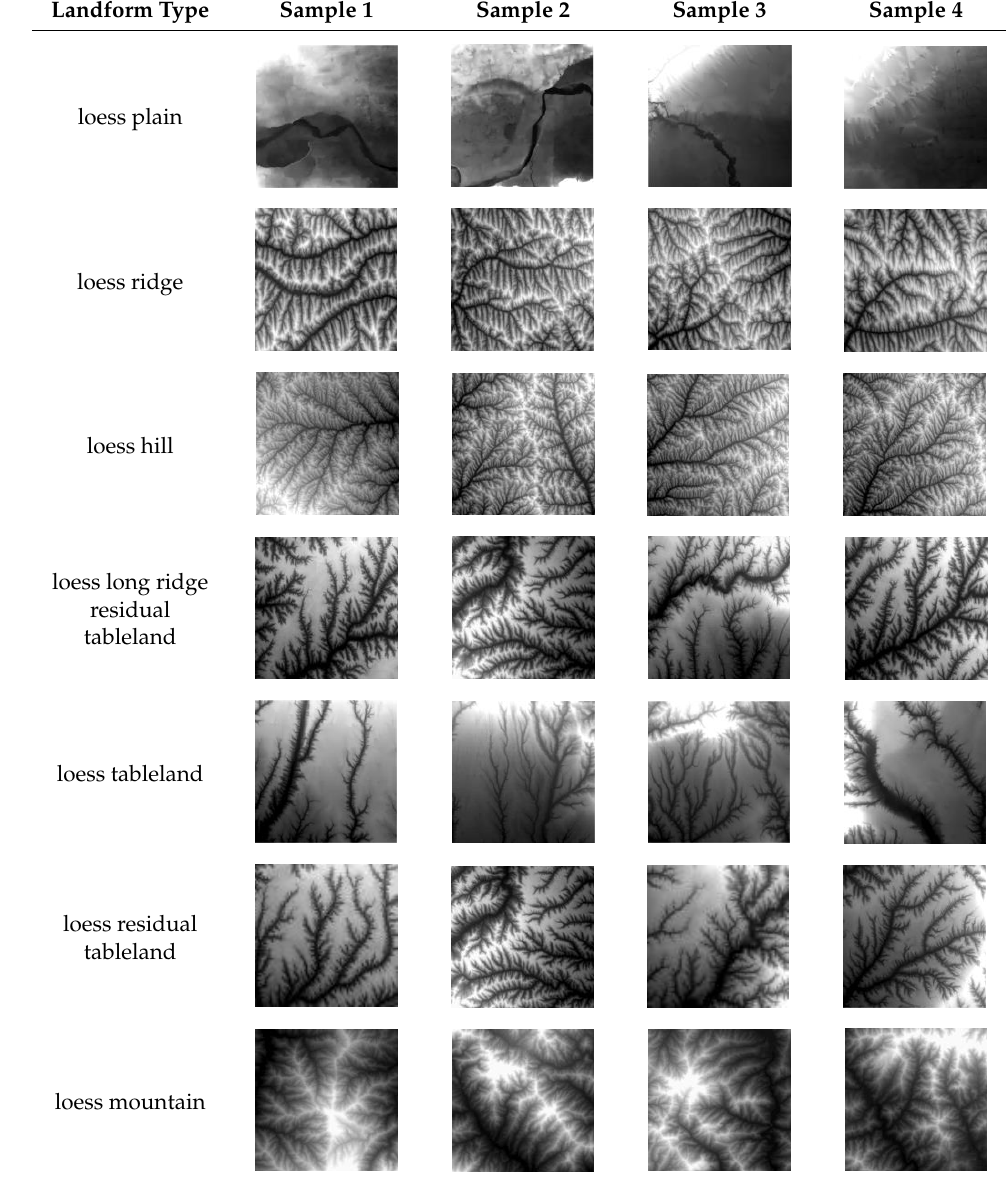
Table 1. Training samples of typical landforms.